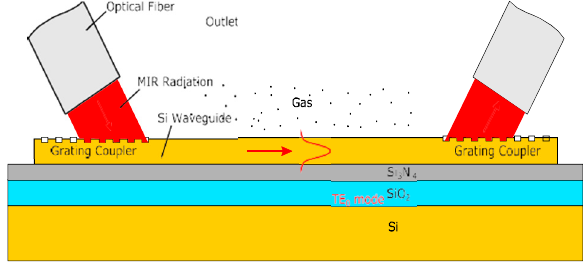
Figure 1. Schematic representation of the sensor idea: Mid-Infrared radiation from a quantum cascade laser is guided to the structure via an optical fibre. Diffraction gratings and taper structures on both ends of the waveguide are used for coupling the light into and out of the